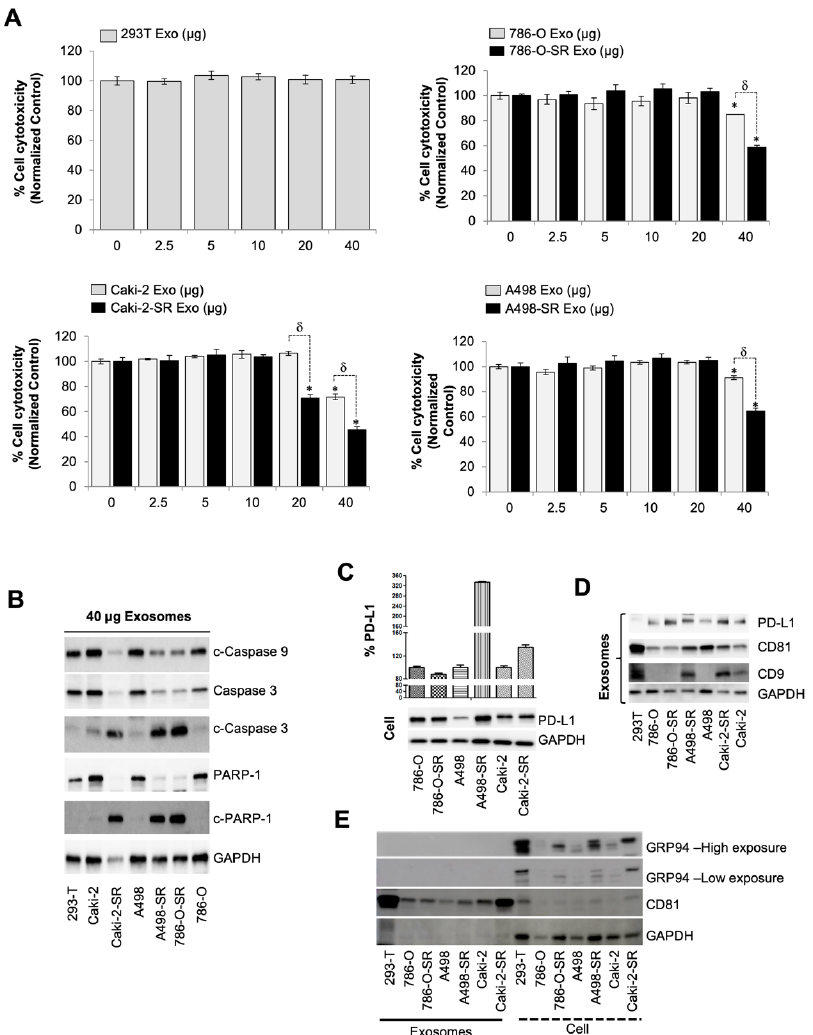
Figure 1. SR RCC exosome’s role in suppressing the immune system. ( A ) Effect of isolated exosomes from 293T or various RCC cells on Jurkat T cell proliferation determined by WST-8 assay after 72 h incubation ( n = 4). ( B ) Caspase activation in Jurkat T cells after dosing with 40 µ g/mL exosomes for 72 h. Caspases 3, 9, and PAPR-1 were then assessed using western blotting. GAPDH was used as an internal control. Full blots are presented in Supplementary Figure S8. ( C ) PD-L1 protein in ccRCC cell lines was detected by western blotting. Full blots are presented in Figure S5. ( D ) Western blot analysis of the expression of exosomal PD-L1, CD9, CD81, and GAPDH in 293T, or SS, or SR RCC cell lines. ( E ) Western blot analysis of exosome and cell lysates identifying the presence of GRP94, a marker specific to large EVs, only in the latter. Full blots are presented in Supplementary Figure S8. * p < 0.05, and δ p <